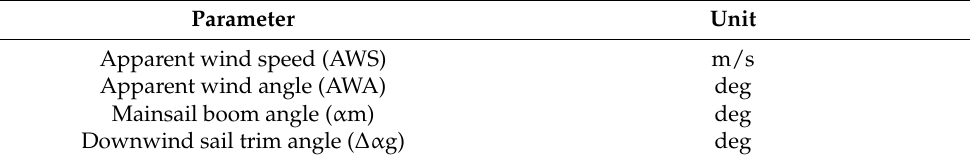
Table 1. Computational fluid dynamics (CFD) analysis parameters.